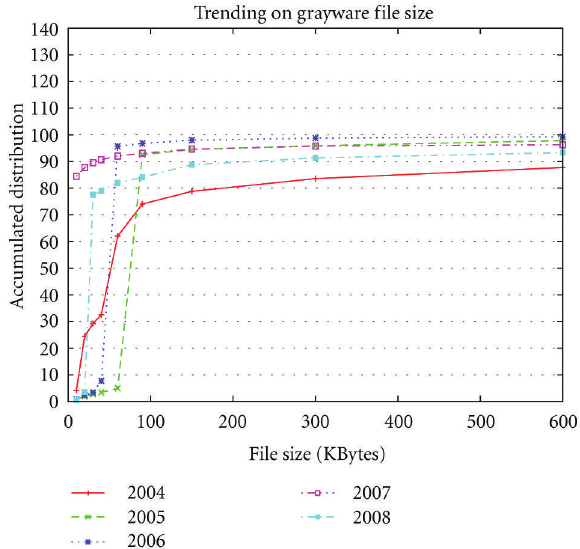
Figure 23: Accumulated grayware distribution on Discovery Date and File